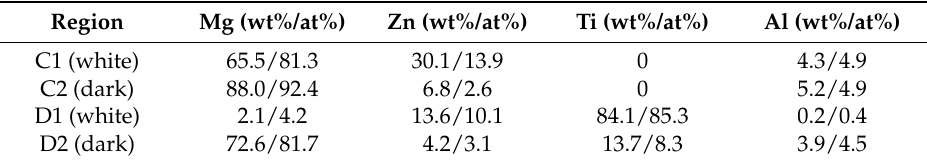
Table 2. Corresponding EDS weight/atomic composition for Figure